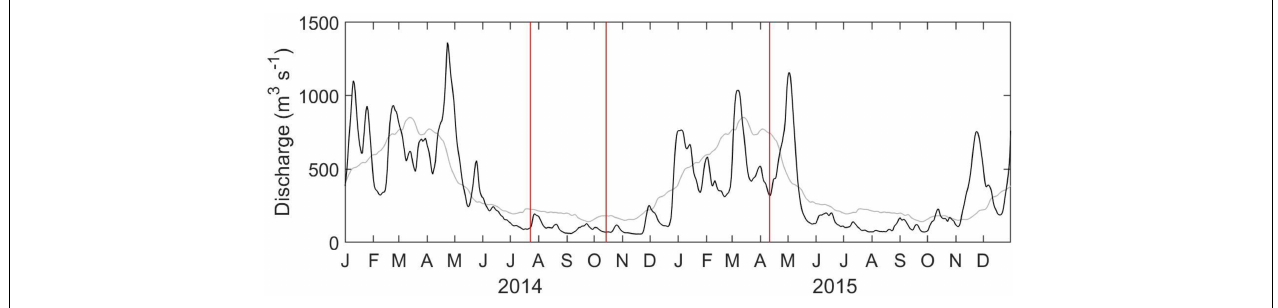
FIGURE 2 | Time series of Altamaha River discharge at Doctortown, Georgia (black). Long-term average is shown in gray. Red vertical lines indicate sampling periods.